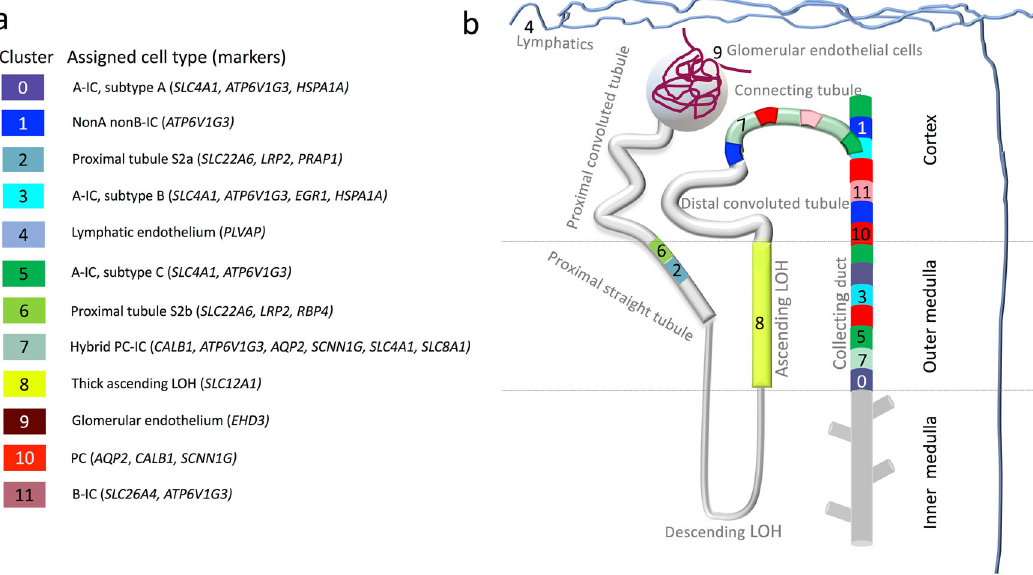
Fig. 2 Cell types assigned to each cluster based on marker gene expression. a The cell types and the gene markers from Fig. 1b, c used to assign the cell type are presented. The colors in the key correspond to the cluster colors from Fig. 1a. ICs were identi fi ed by ATP6V1G3 (a subunit of V-ATPase) expression and consisted of clusters 0, 1, 3, 5, 11, and 12. A-ICs were identi fi ed by SLC4A1 expression and consisted of 0, 3, 5, and 7. B-ICs were identi fi ed by SLC26A4 expression that was limited to cluster 11. PCs were identi fi ed by AQP2 expression which was prominent in clusters 7 and 10. While cluster 10 appeared to be traditional PCs, cluster 7 were hybrid PCs – ICs that expressed both AQP2 and SLC4A1. SLC8A1 was highly selective to hybrid PC – ICs that also expressed CALB1 , indicating that these cells might originate in the connecting segment. There were three subtypes of A-ICs that were characterized by HSPA1A and EGR1 expression: A-IC subtype A/cluster 0 expressed HSPA1A , A-IC subtype B/cluster 3 expressed both HSPA1A and EGR1 , A-IC subtype C/cluster 5 expressed neither HSPA1A nor EGR1 . b The expected location of the cell types within the kidney is